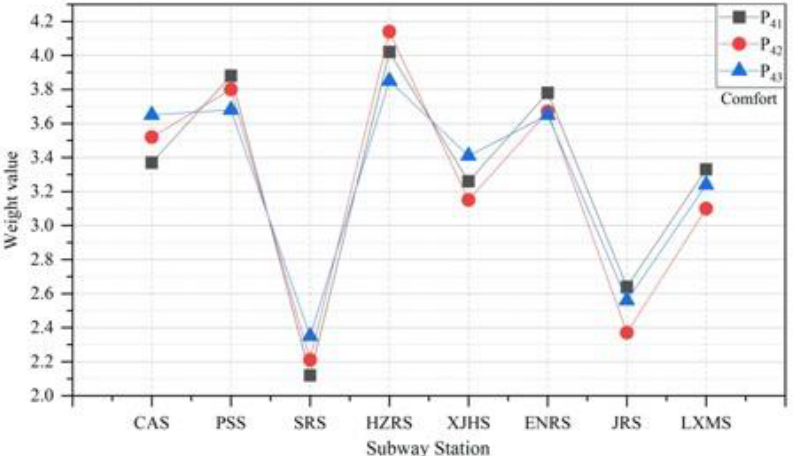
Figure 14. The evaluation results of the evaluation index of the environmental comfort of the transfer spaces of sample stations.